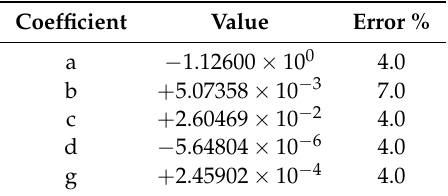
Table 1. Coefficient values from Equation (19) and percentage errors with respect to data obtained from [8].